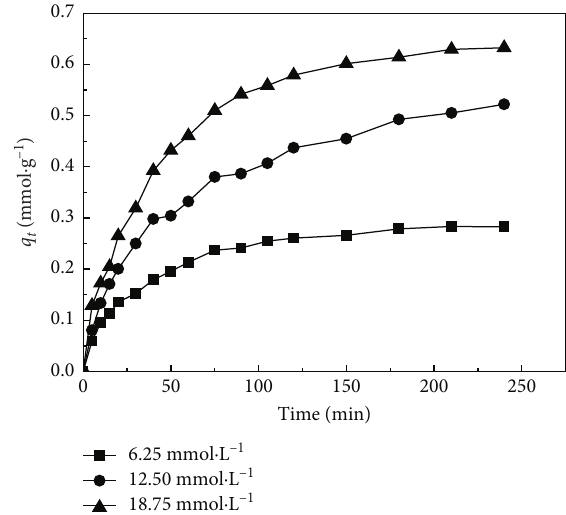
Figure 8: Effects of initial concentration onto Mn/AC (model oil with different c 0 :6.25, 12.50 and 18.75mmol L − 1 ; v sorbents, 0.2g 2wt. % Mn/AC; adsorptive temperature, 313 K).